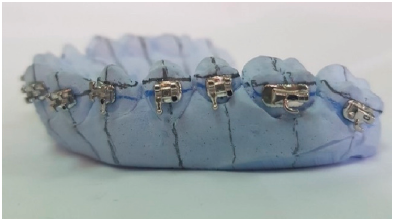
Figure 2: Unaltered orthodontic attachments group (UA).